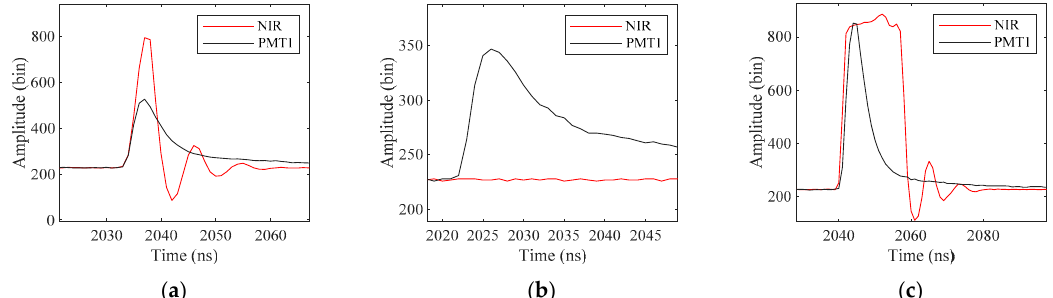
Figure 14. The ( a ) normal, ( b ) buried and ( c ) saturated NIR signals. The NIR signals are not always reliable. Sometimes the surface signal is buried below the noise level which cannot be detected, because its strength is not within the dynamic range of the receiver. Sometimes the surface signal is saturated, because the receiving direction of the sensor is approximately in the reflection direction of sunlight.